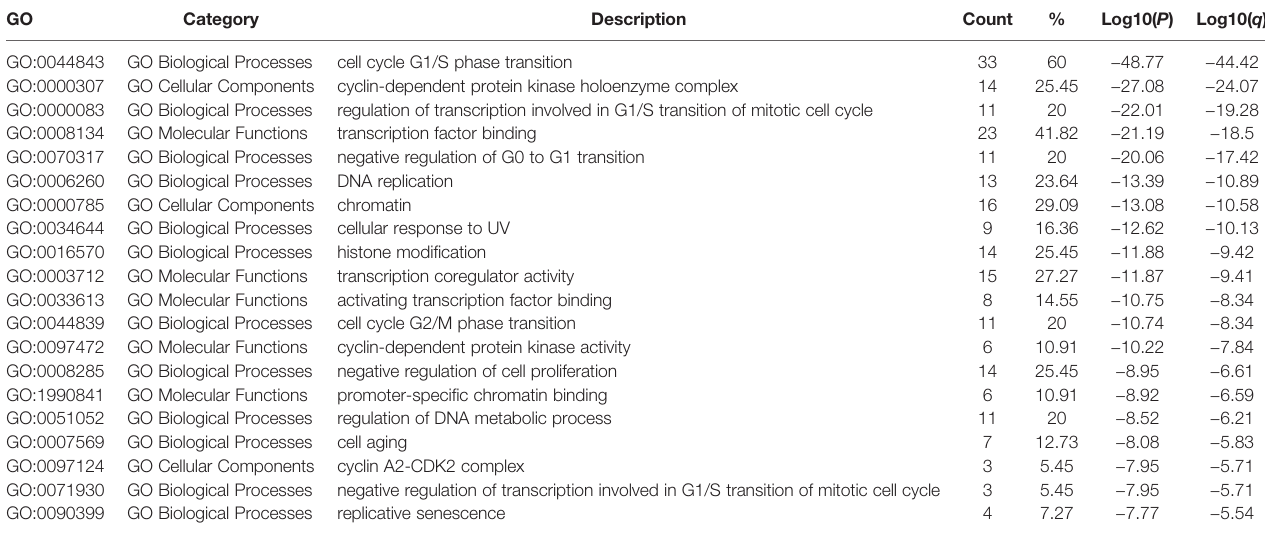
TABLE 2 | The GO function enrichment analysis of E2Fs and neighbor genes in PAAD (Metascape). GO